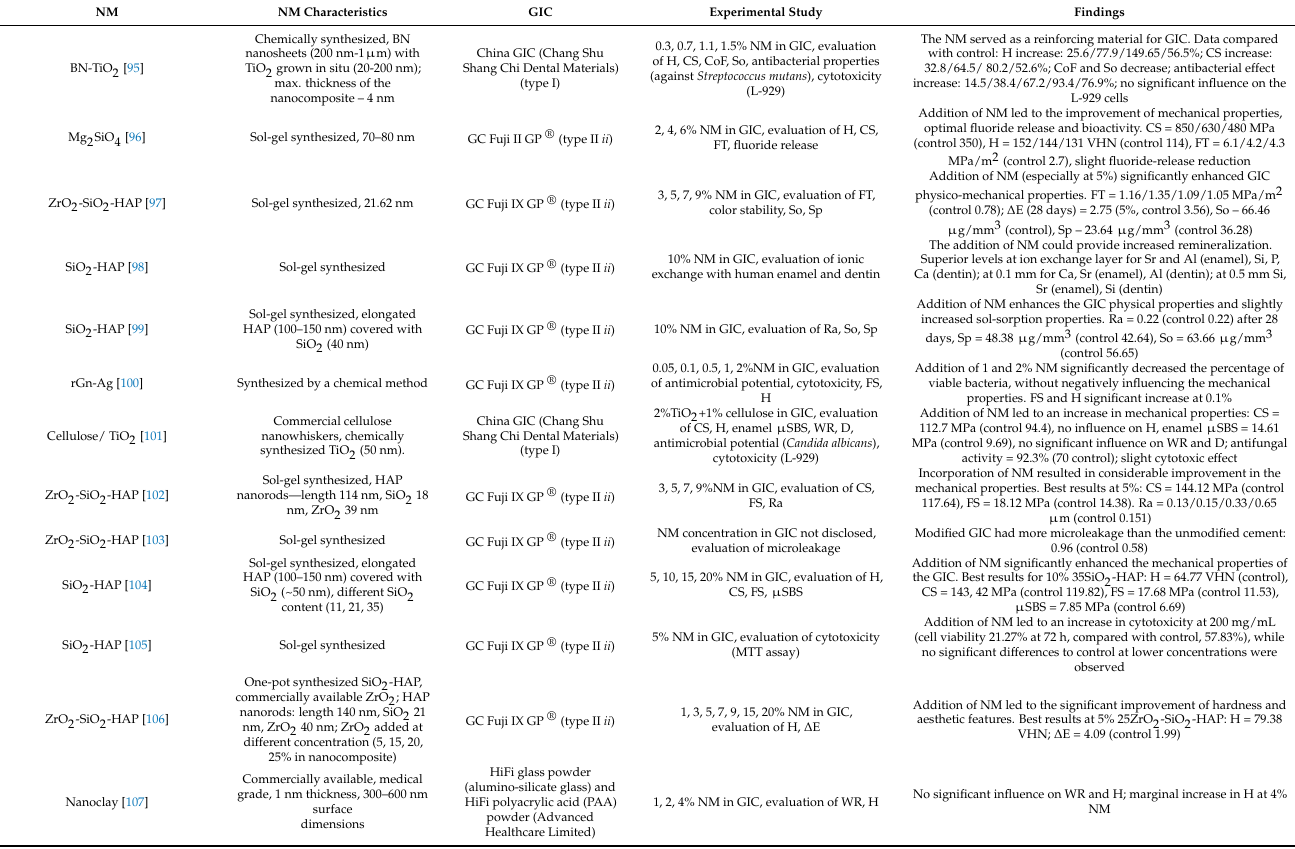
Table 6. Examples of other types of nanomaterials incorporated in GIC (references presented in chronological order) 1